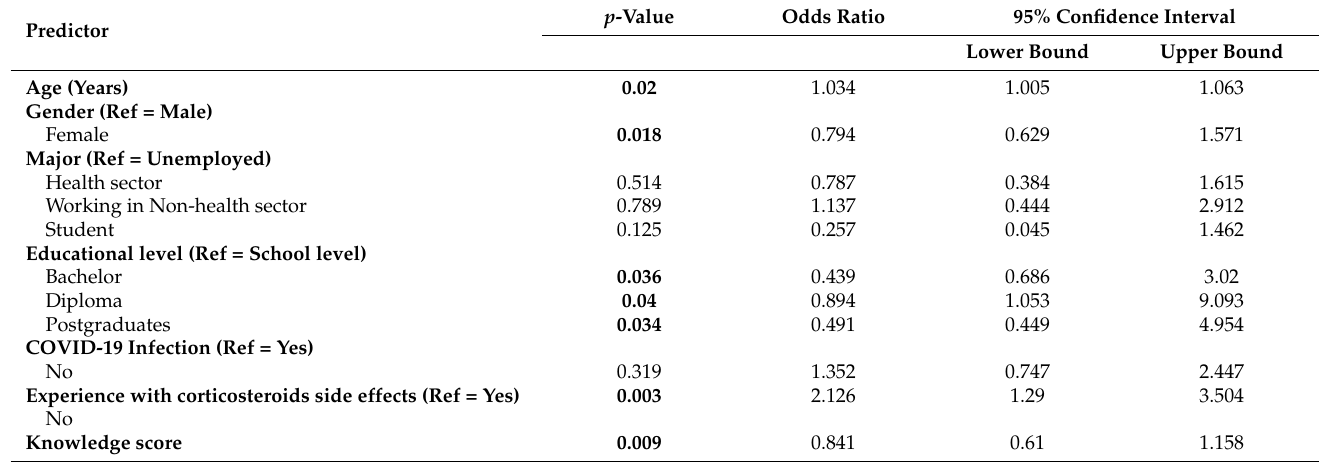
Table 6. Multivariable logistic regression analysis for the identified independent variables associated with high scores (3.33–5.00) on the Likert scale for